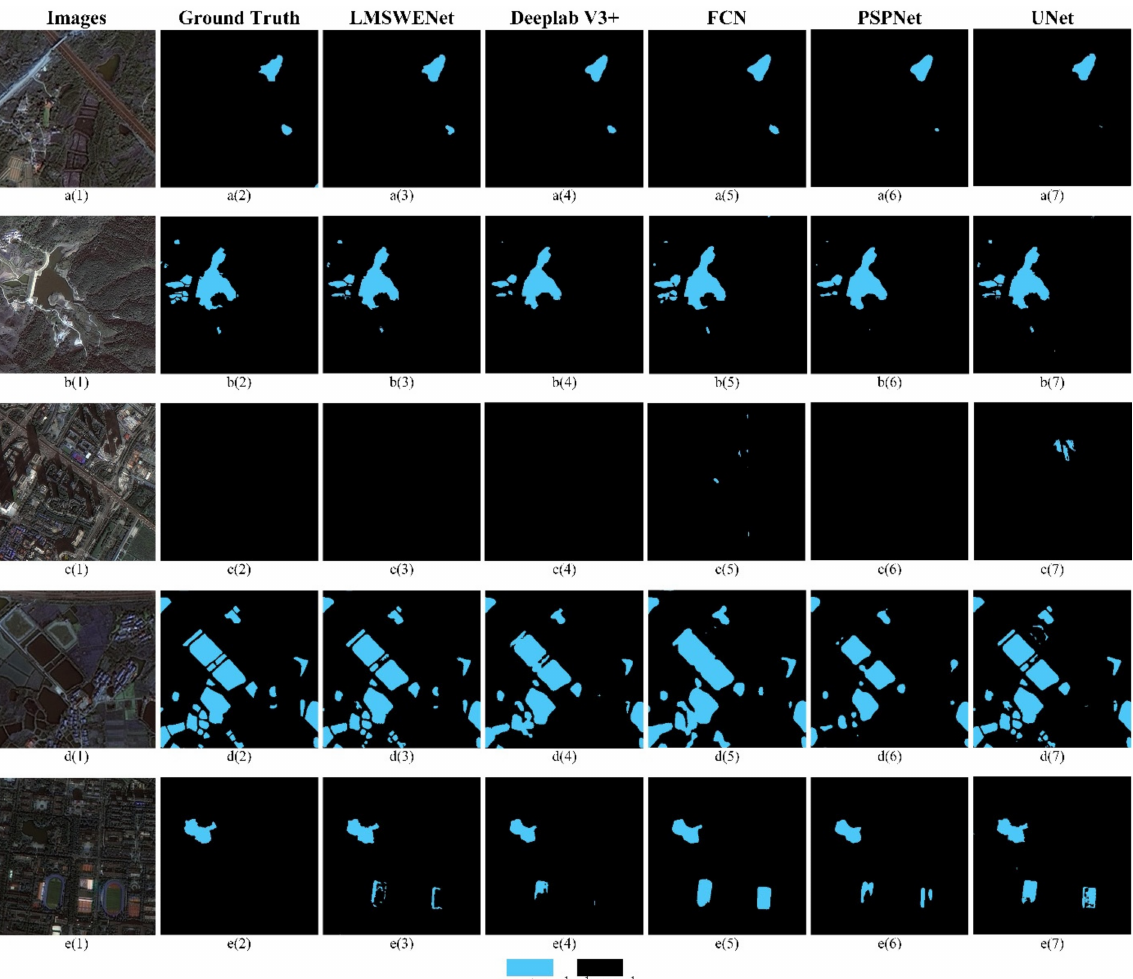
Figure 10. Land surface water information extraction results in a confusing area. ( a ( 1 )) is the raw image of highways; ( a ( 2 – 7 )) are the water areas extracted from ( a ( 1 )) using manually labeling, LMSWENet, DeeplabV3+,FCN, PSPNet, and UNet, respectively; ( b ( 1 )– e ( 7 )) are the water areas extracted from different surface environments with mountain shadows, architecture shadows, agricultural land, and playgrounds,